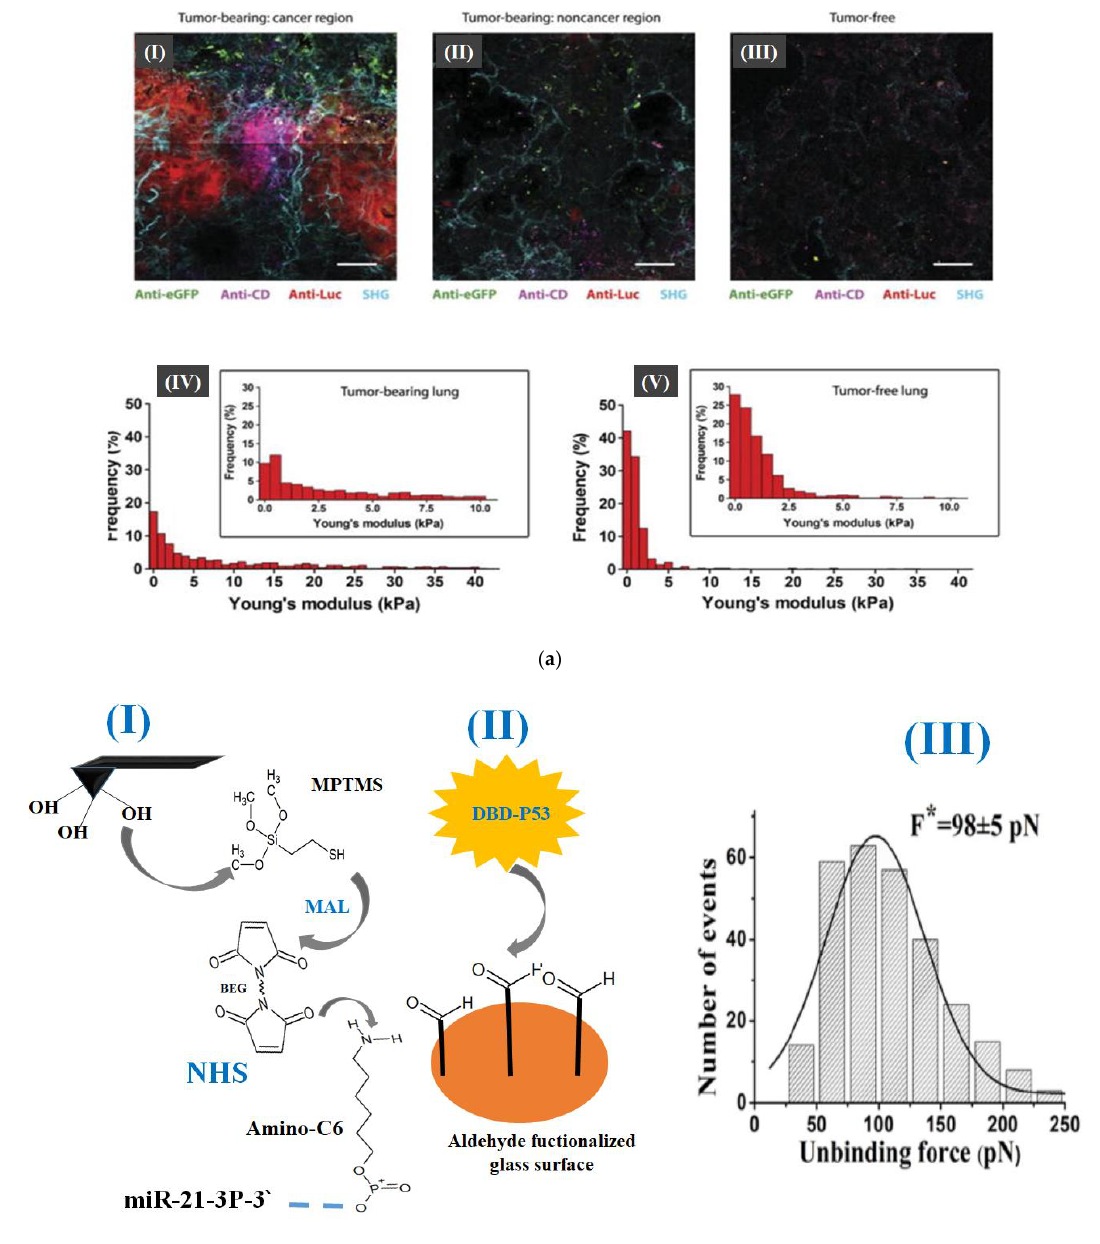
Figure 6. ( a ). Specific activation of MRCS in response to mechanical cues in the metastatic niche in-vivo . Frozen lung sections of tumor-bearing NSG mice cancer region (I) and noncancer region (II) and tumor-free NSG mice (III) after infusion of MRCS-CD cotransfected with eGFP were stained with anti-Luc (red) to detect lung metastasis, anti-CD (magenta) for CD expressed by MRCS-CD, and anti-eGFP (green) for MRCS-CD tracking. SHG imaging of collagen networks (cyan) was also overlaid on IHC imaging. (IV) and (V ) Frequency of Young’s modulus values of cancer bearing and tumor-free (VI) lungs from AFM microindentation in the range of 0 to 40 kPa (bin size = 1 kPa), whereas the inset graphs show the frequency within the range of 0 to 10 kPa (bin size = 0.5 kPa). The Figure is adapted with permission from Ref. [87]. 2022, Elsevier. (b). AFM technique deployed to investigate the molecular interaction between the pro-oncogenic miR-21-3p and the tumor suppressor p53 . Schematic depiction of the surface chemistry used to covalently bind (I) miR-21-3p and DBD of p53 (ii) to AFM tips and substrate, respectively. (III) SMFS histogram of the unbinding forces for the DBD-miR-21-3p complex [87].